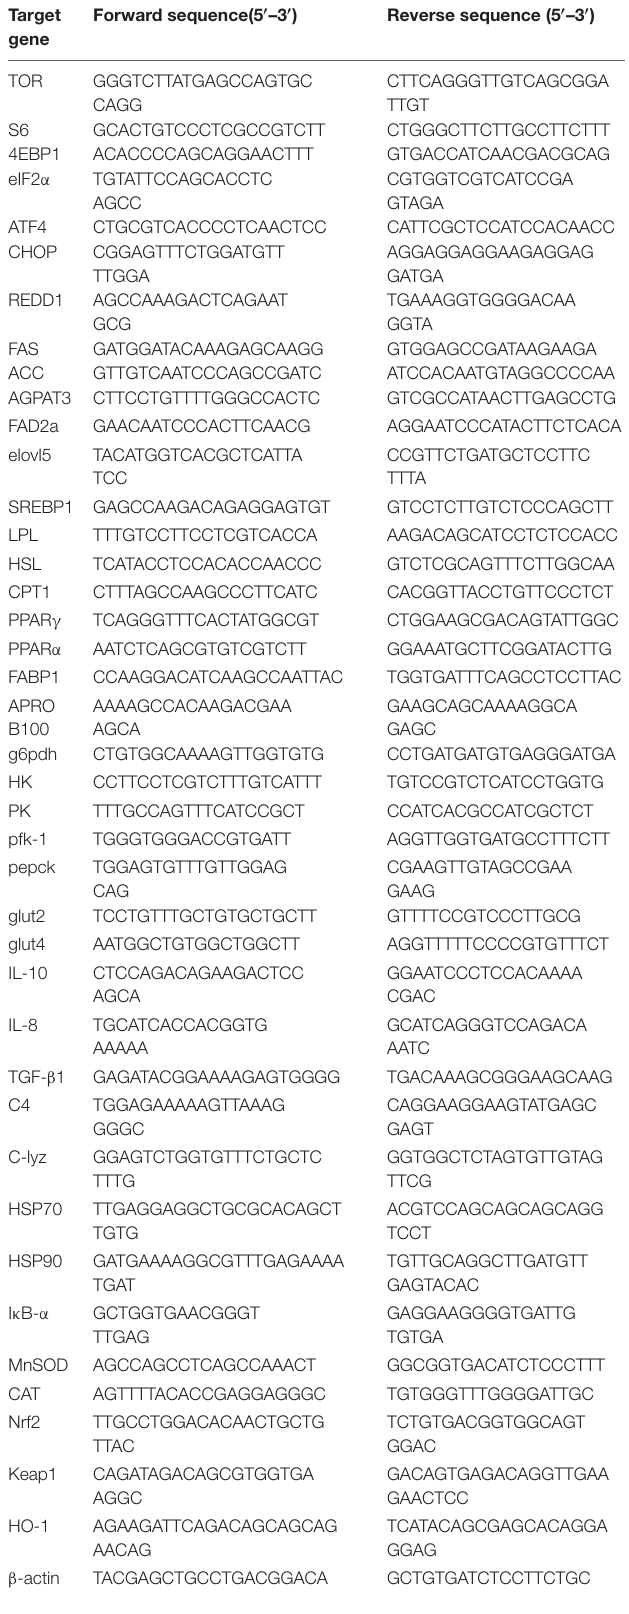
TABLE 3 | The sequences of the primers used in the RT-PCR. Target Forward sequence(5 (cid:48) –3 (cid:48) ) Reverse sequence (5 (cid:48) –3 (cid:48) gene